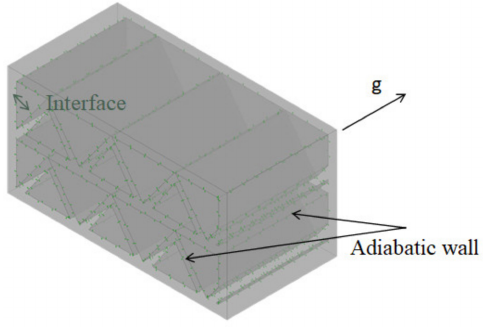
Figure 5. Boundary conditions.